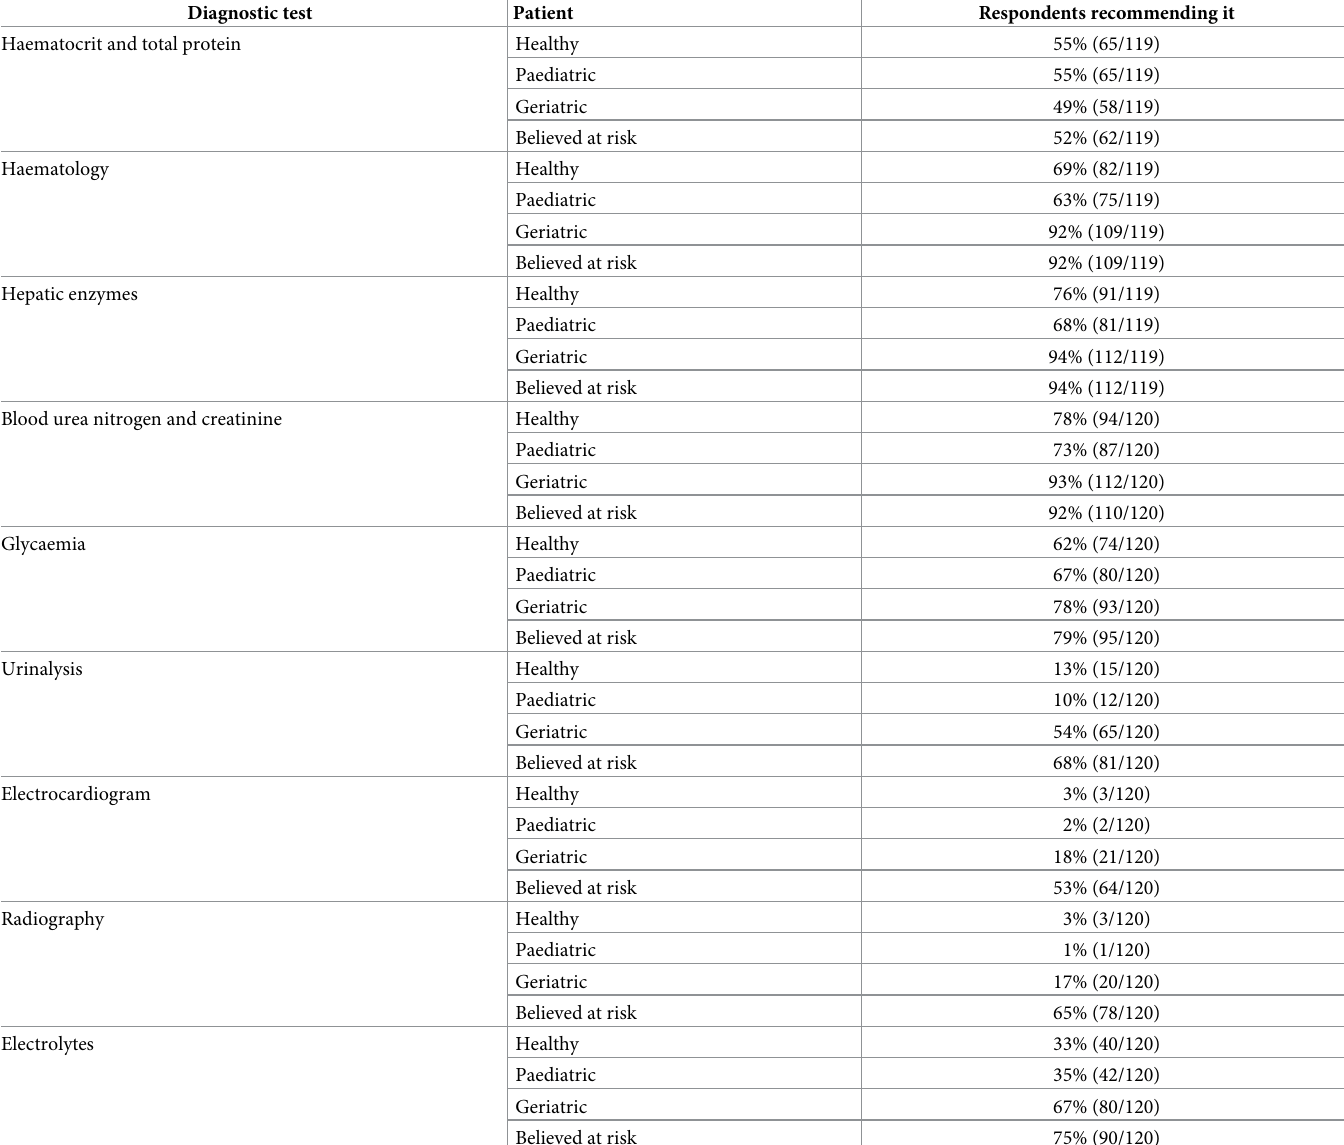
Table 4. Additional diagnostic tests recommended by English-speaking veterinarians for each patient